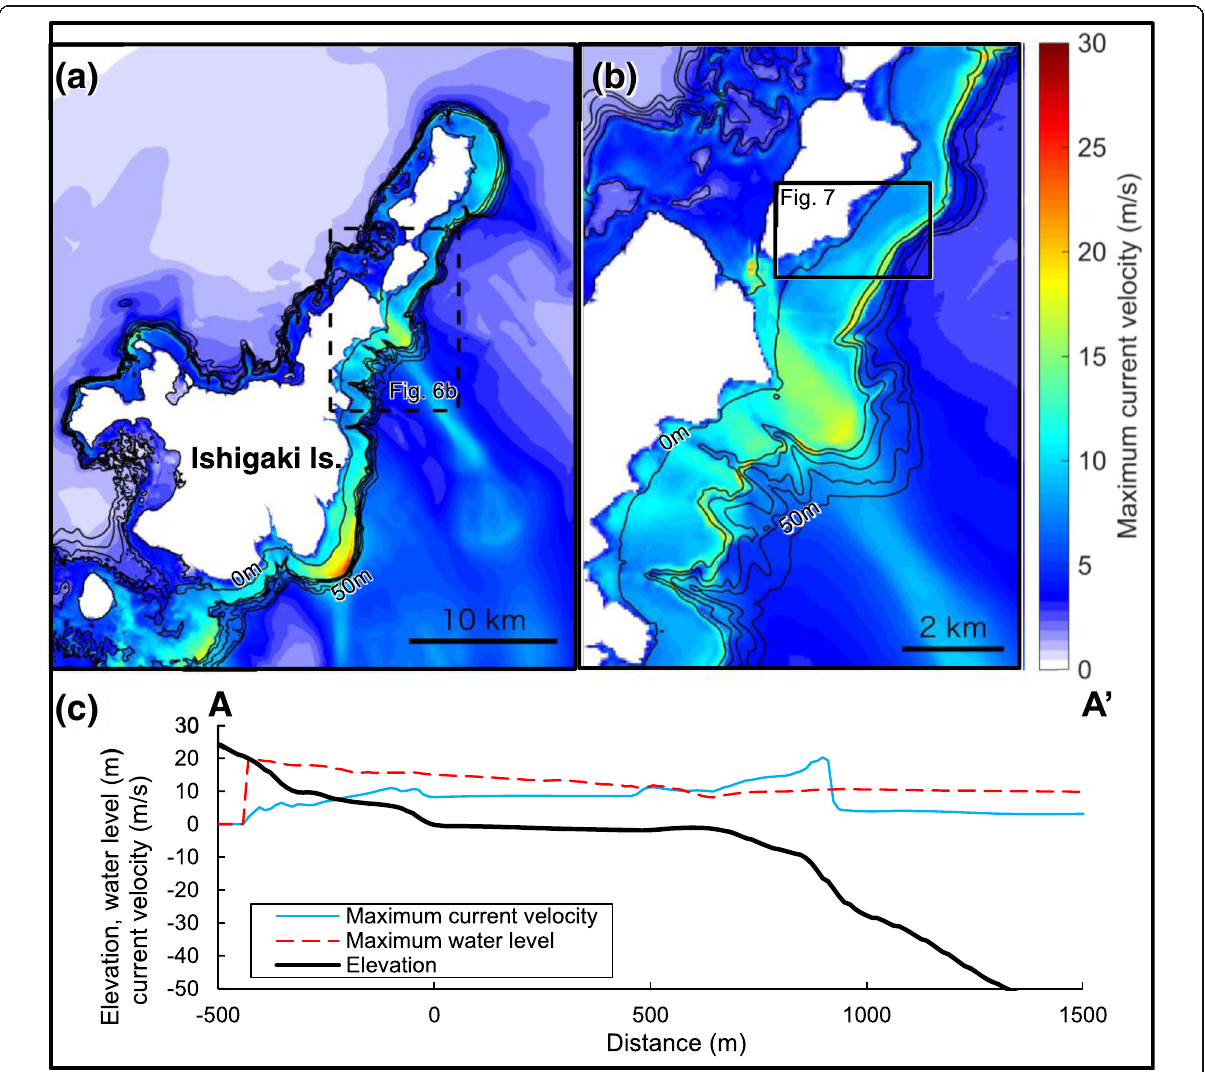
Fig. 6 a Numerical result for the absolute value of the maximum tsunami current velocity (m/s) around the Ishigaki Island and b around the Ibaruma reef. c Cross-sectional profiles of elevation (m), maximum water level (m), and maximum current velocity (m/s) at the Ibaruma reef. The transect location is depicted in Fig.